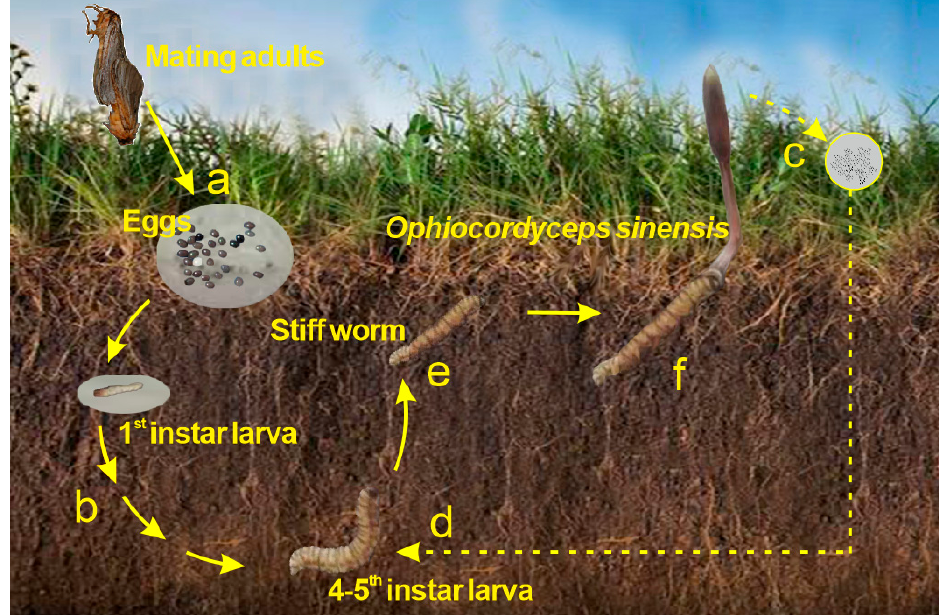
Figure 1. Life history of Ophiocordyceps sinensis ( O. sinensis ). (a) The eggs of the host Thitarodes insect, which are scattered on the grassland, incubate; (b) The host larvae safely reside in the soil throughout the long-lasting larval stage; (c) The ascospores erupt from mature fruiting bodies of O. sinensis ; (d) The 4–5th instar larvae may be infected by the infective conidia of the O. sinensis fungus in the soil; (e) The caterpillar-shaped sclerotium (winter-worm) is formed; (f) The stroma germinates out of the head capsule and the mature O. sinensis (summer-grass-winter-worm) is formed.